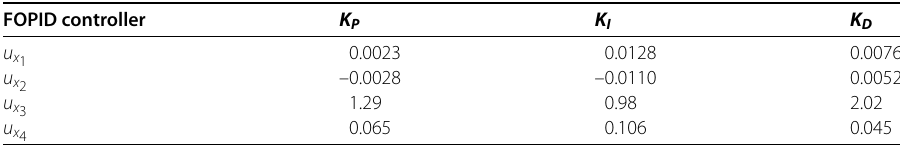
Table 1 FOPID controller gain values optimized with GA